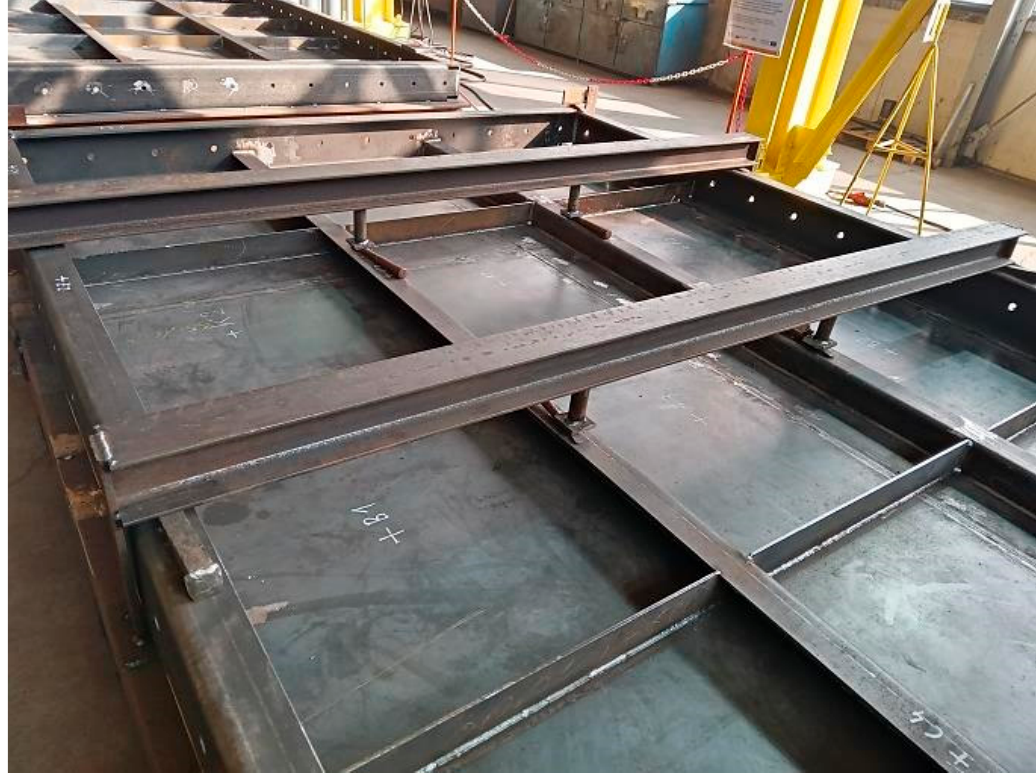
Figure 9. View of the furnace wall panel elements connected by spot welds to the restraint system according to model 1. according to model